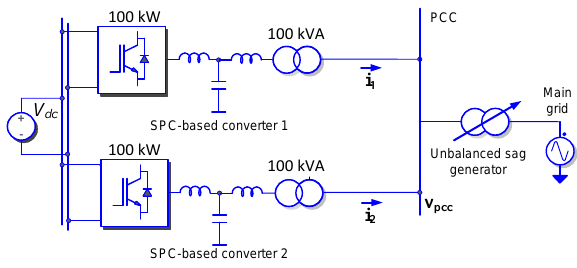
Figure 12. Experimental setup for unbalanced voltage sag tests. Energies 2017 , 10 , 950